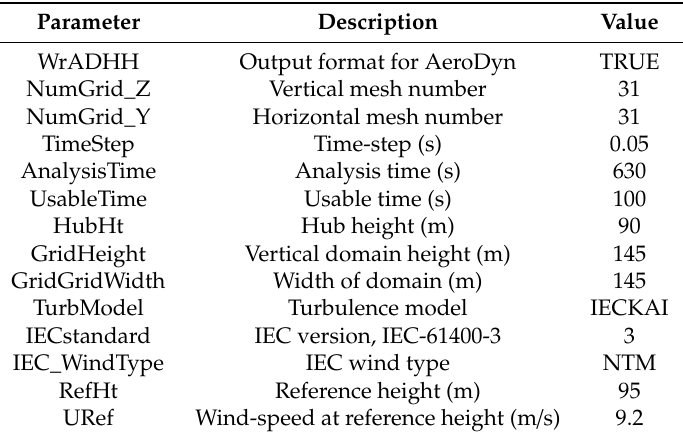
Table 3. Input file description (Turbsim) (DLC 1.2).